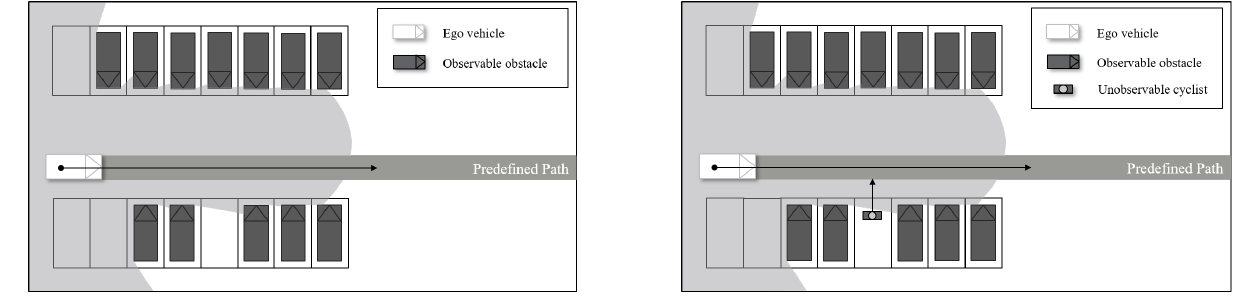
Figure 9. Scenario